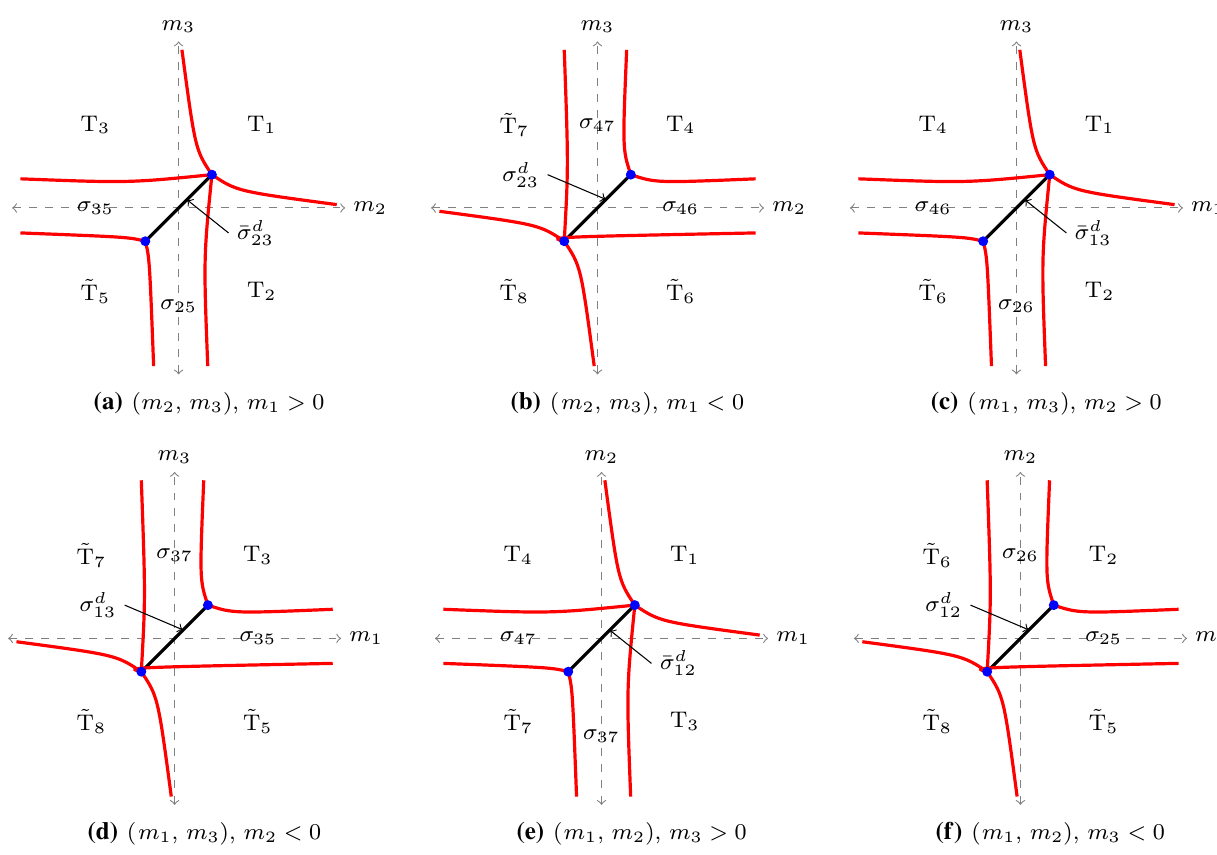
Fig. 12 Phases of SU ( N ) k + p ψ 1 + q ψ 2 + ( F − p − q )ψ 3 with 0 ≤ k < ( p + q ) − F / 2